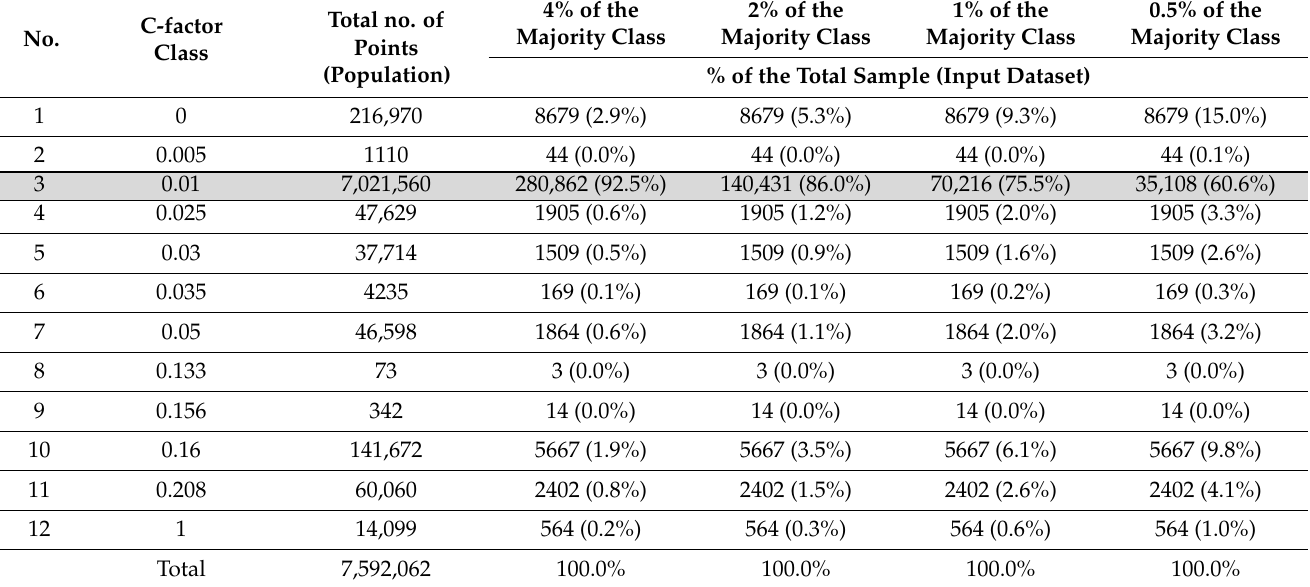
Table 5. The percentage composition of C-factor classes in the input datasets under different majority class sampling rates (C = 0.01